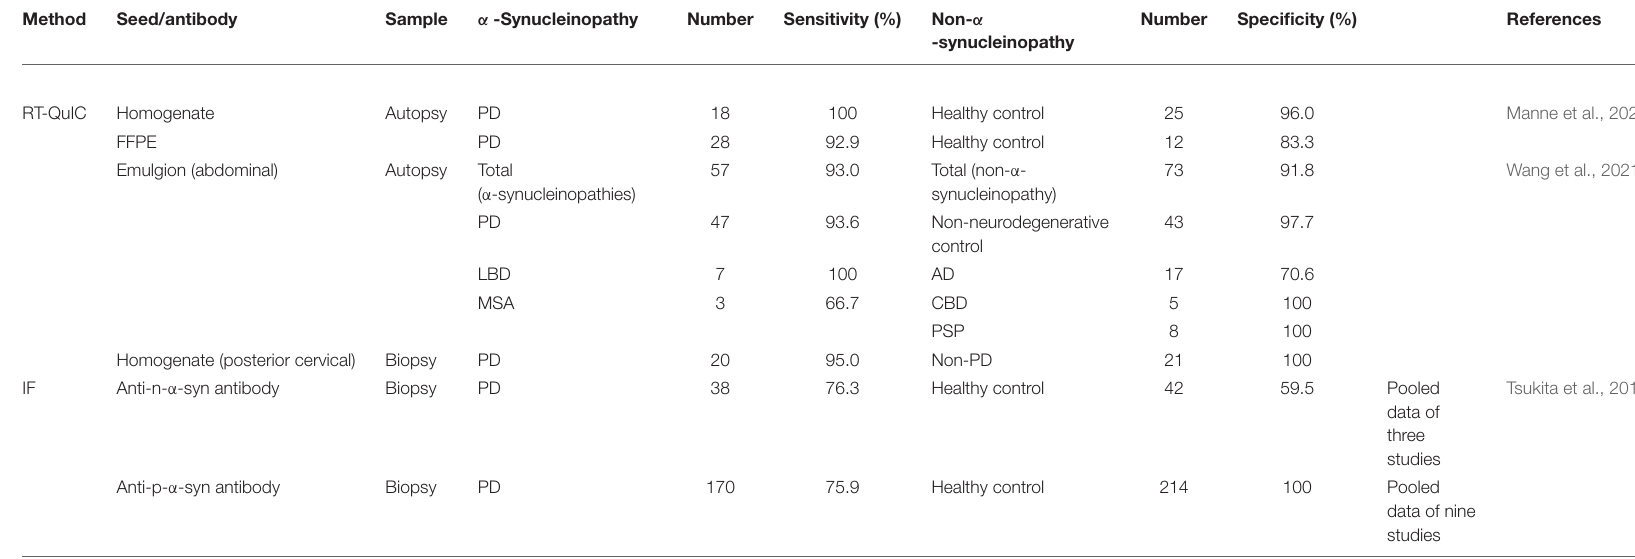
TABLE 2 | Sensitivity and specificity of the detection of abnormal α -synuclein aggregation in skin tissues.